Question: What type of chart is this?
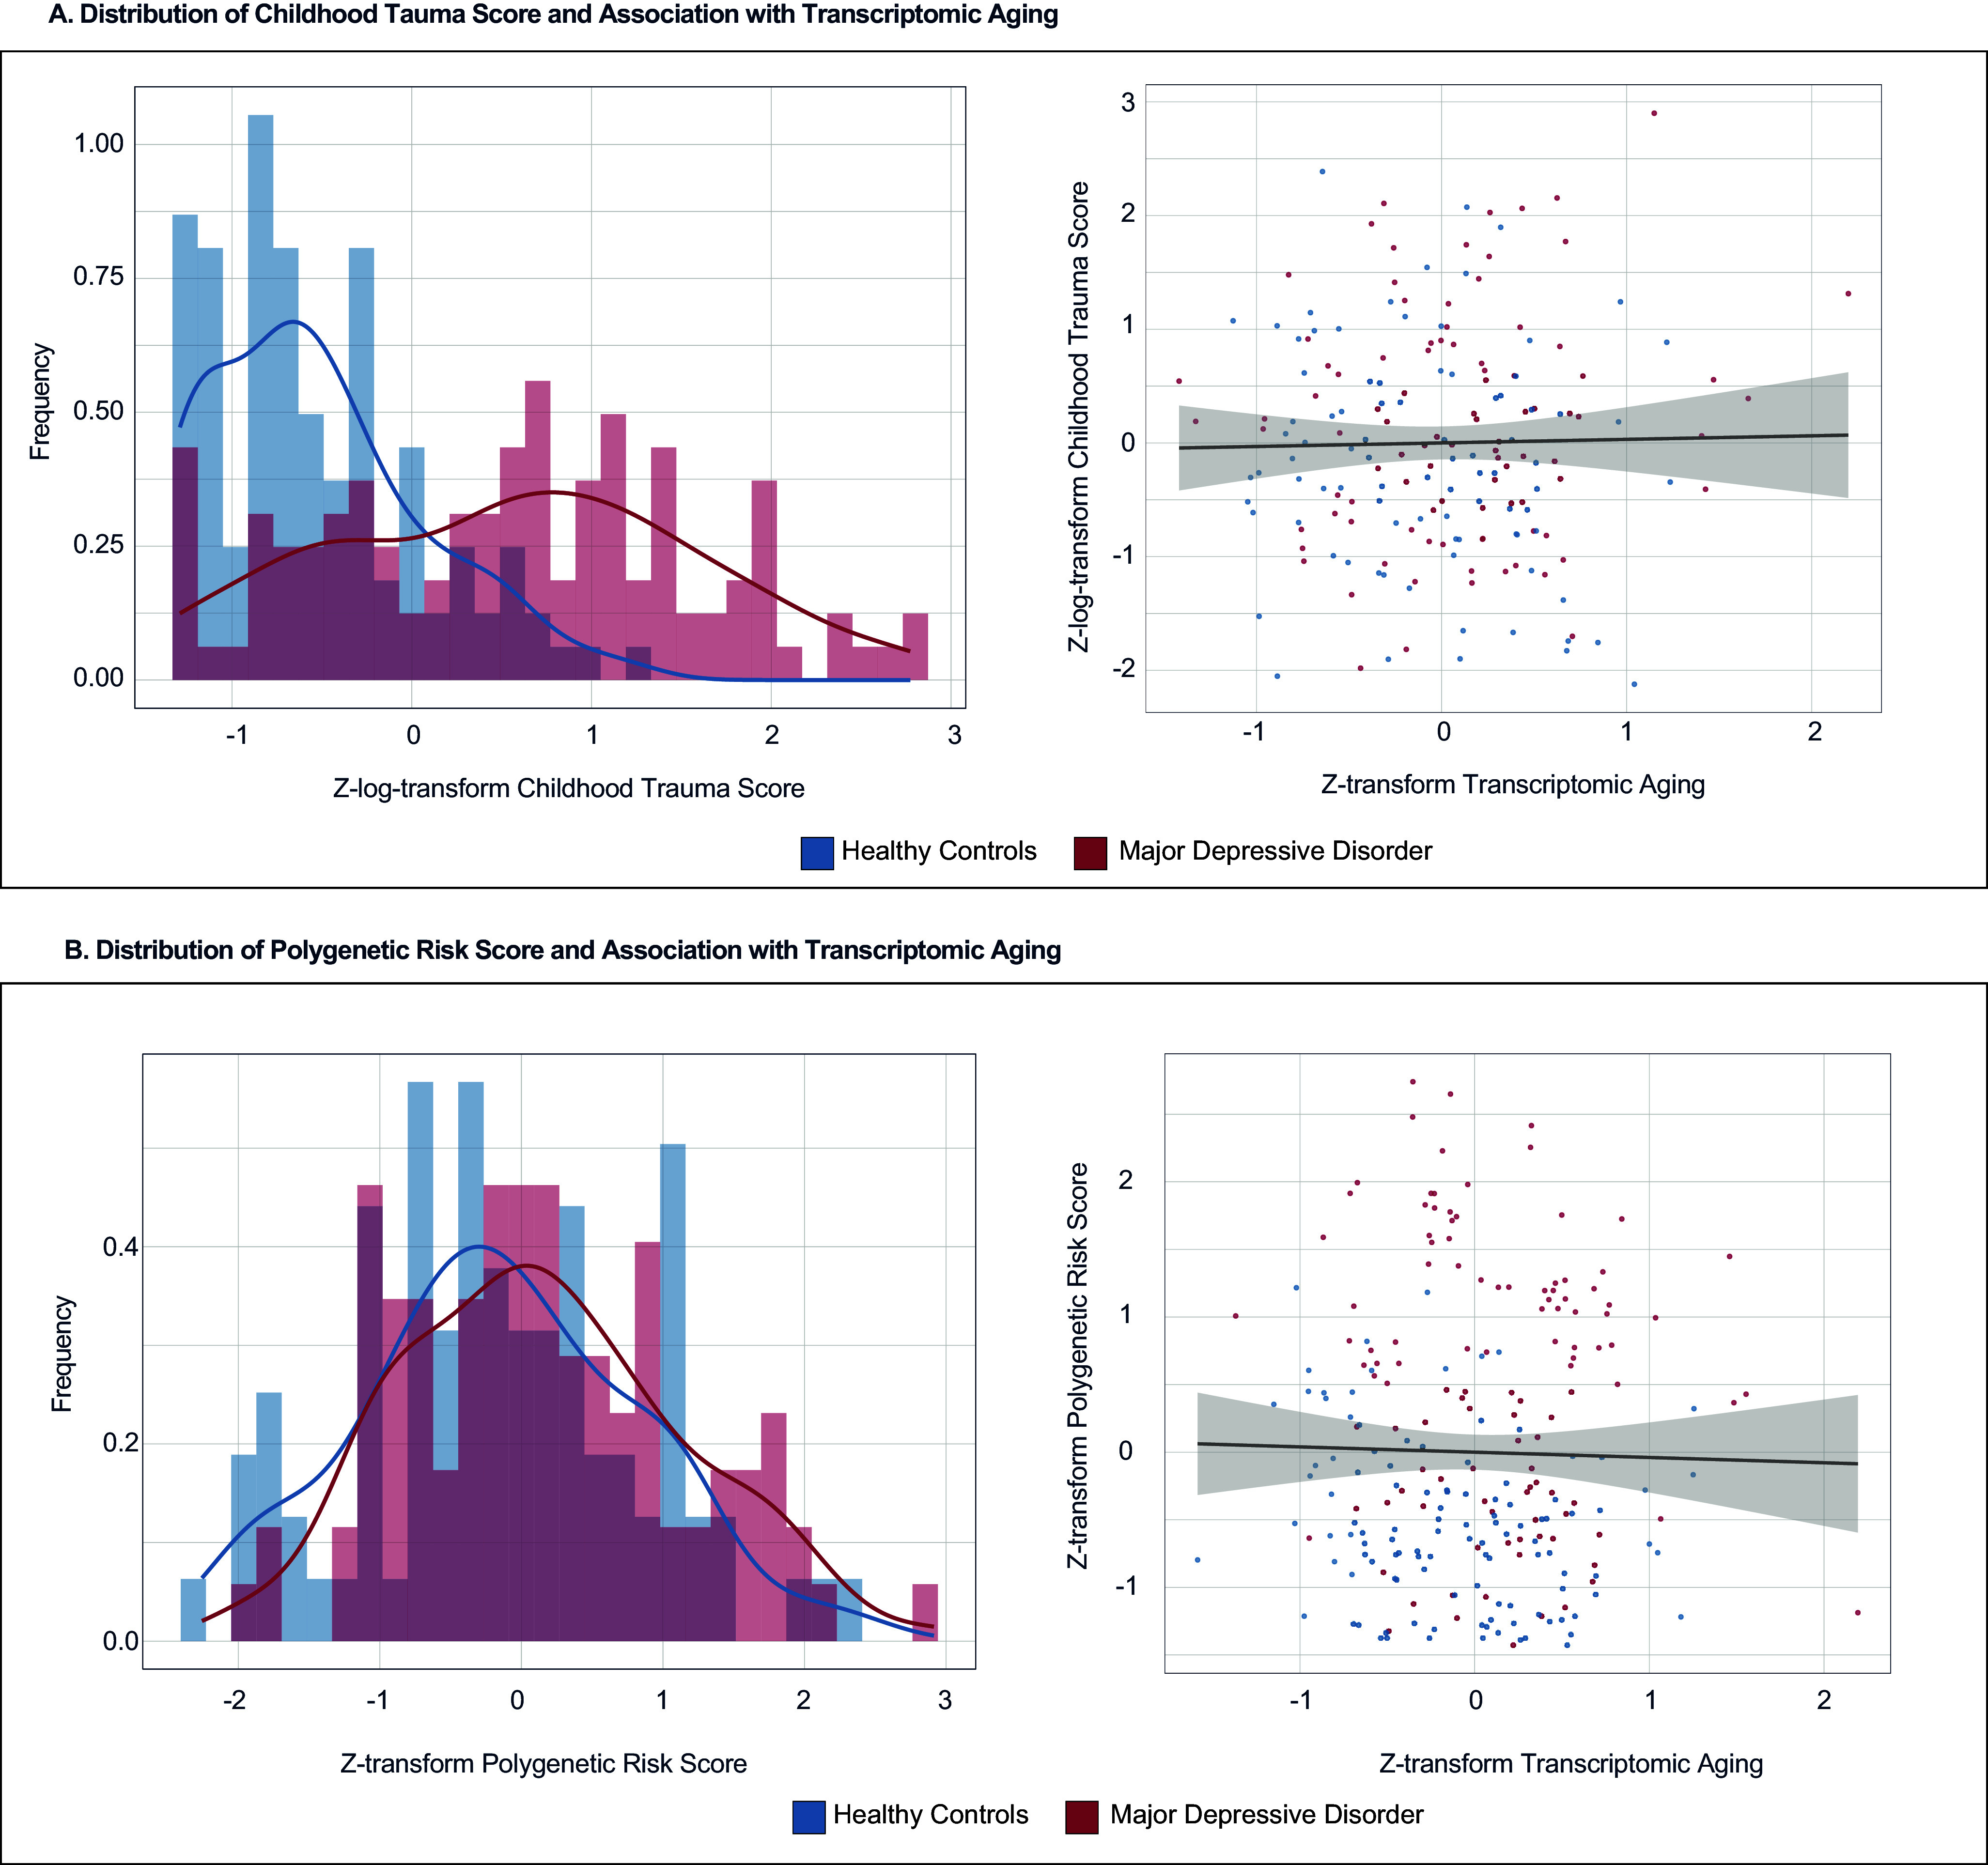
Answer: scatter